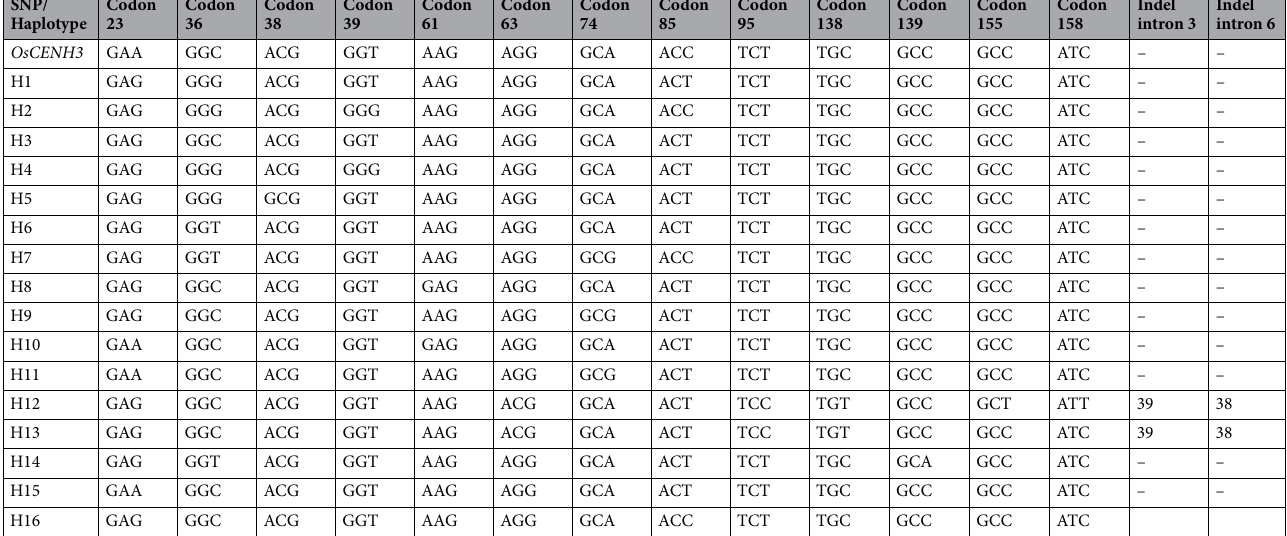
Table 3. Haplotypes based on SNPs from complete CENH3 genic data: the table reports SNP in the affected codons (columns) for sixteen haplotypes (rows).